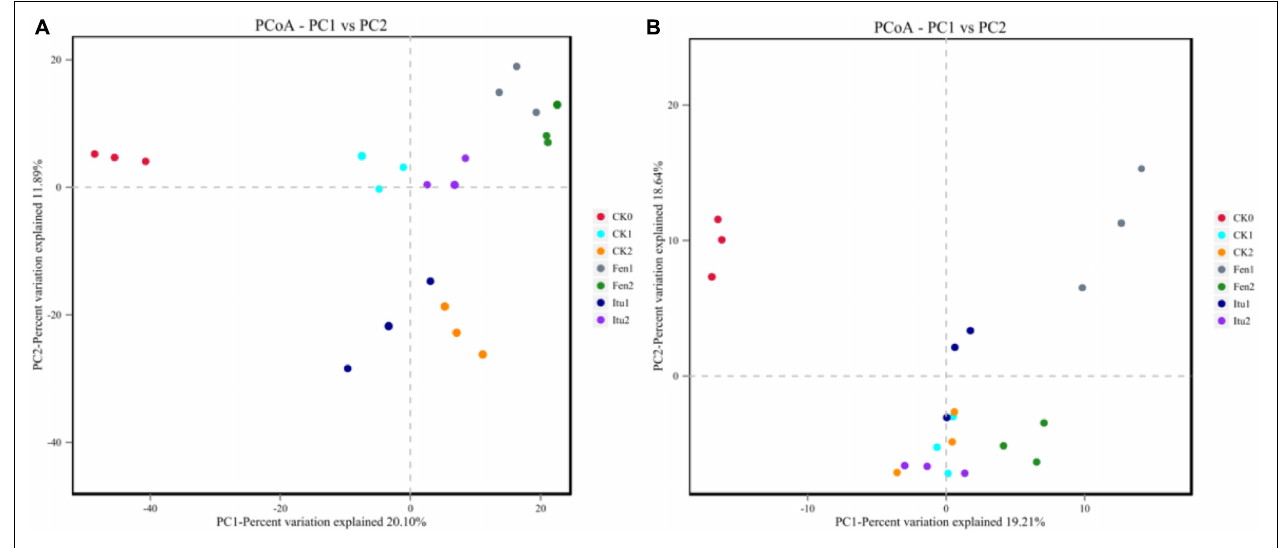
FIGURE 7 | Principal component analysis of fungal (A) and bacterial (B) communities from soil